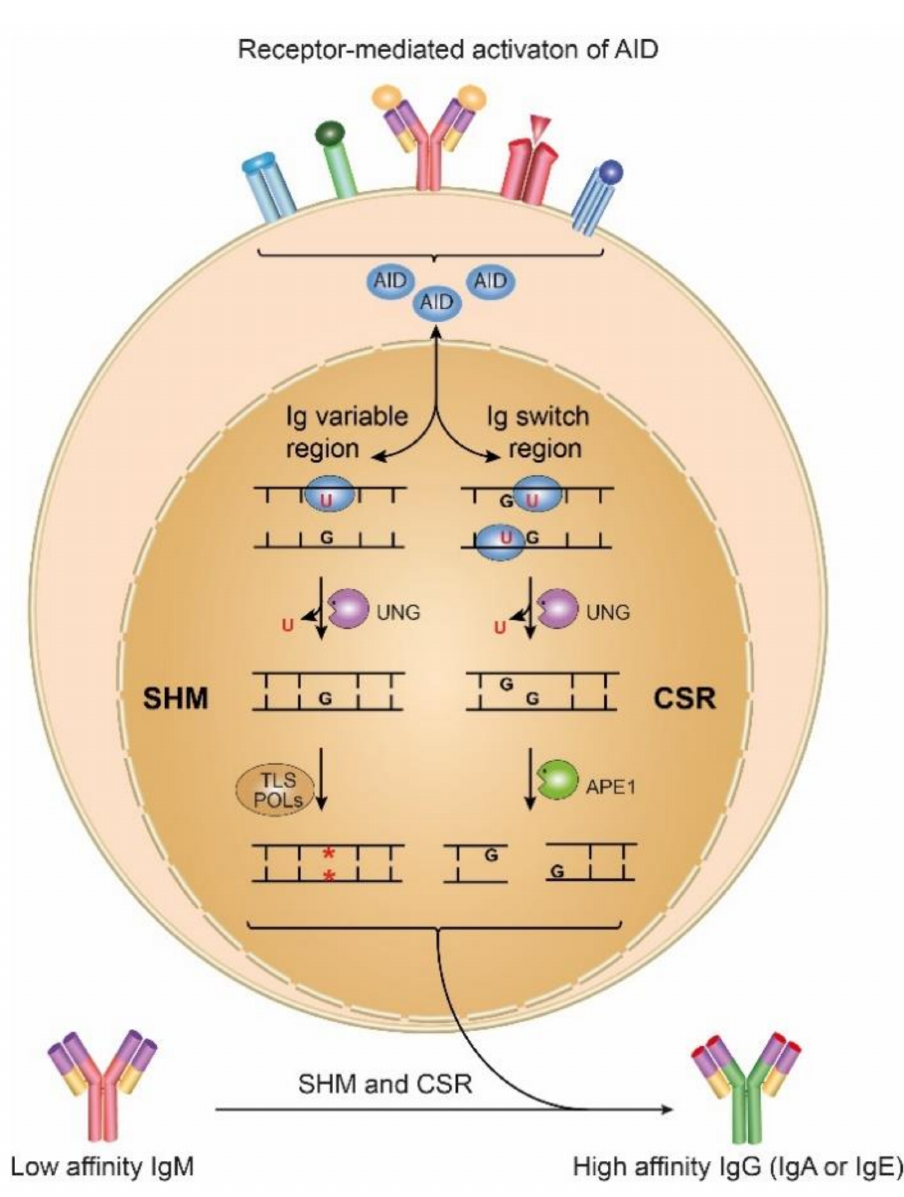
Figure 1. AID initiates SHM and CSR by deaminating cytosine to uracil in Ig variable and switch regions, respectively. In SHM, C → T transitions can be induced by direct replication over the uracil. A full mutation spectrum can be achieved after UNG-mediated excision of uracil and replication over the abasic site by error-prone translesion polymerases, often combined with MMR. In CSR, UNG-mediated removal of uracil followed by strand cleavage at the abasic sites by APE1, leads to DSBs in Ig switch regions. Ig variable segments can then be joined to novel constant region segments by non-homologous end-joining (NHEJ) to form antibodies with novel effector